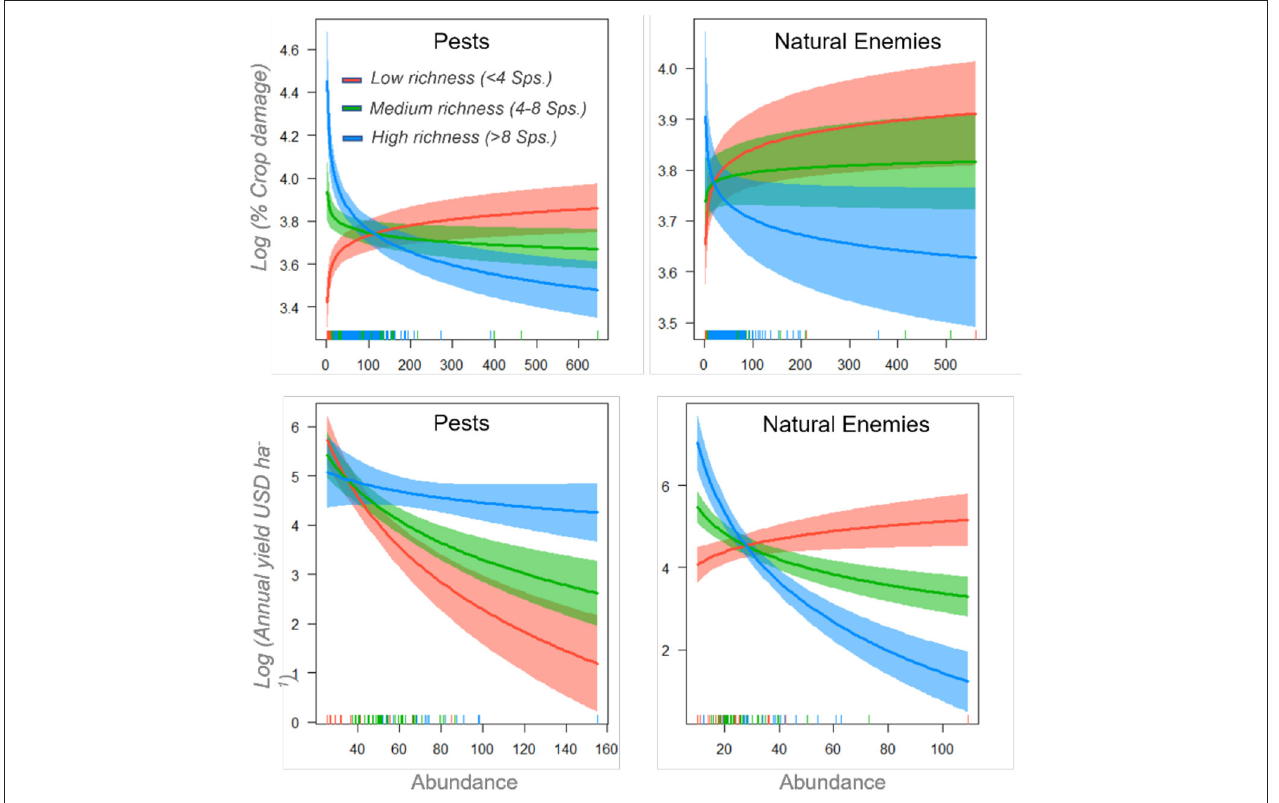
FIGURE 6 | Interactive effects of pest (left panels) and natural enemy (right panels) richness and abundance on percentage crop damage (top panels) and annual income from crop yield in USD (bottom panels). Colors represent the different levels of Species Richness – low (red), medium (green), and high (blue). Abundance was log-transformed in the model. The plots indicate back-transformed values for ease of interpretation.